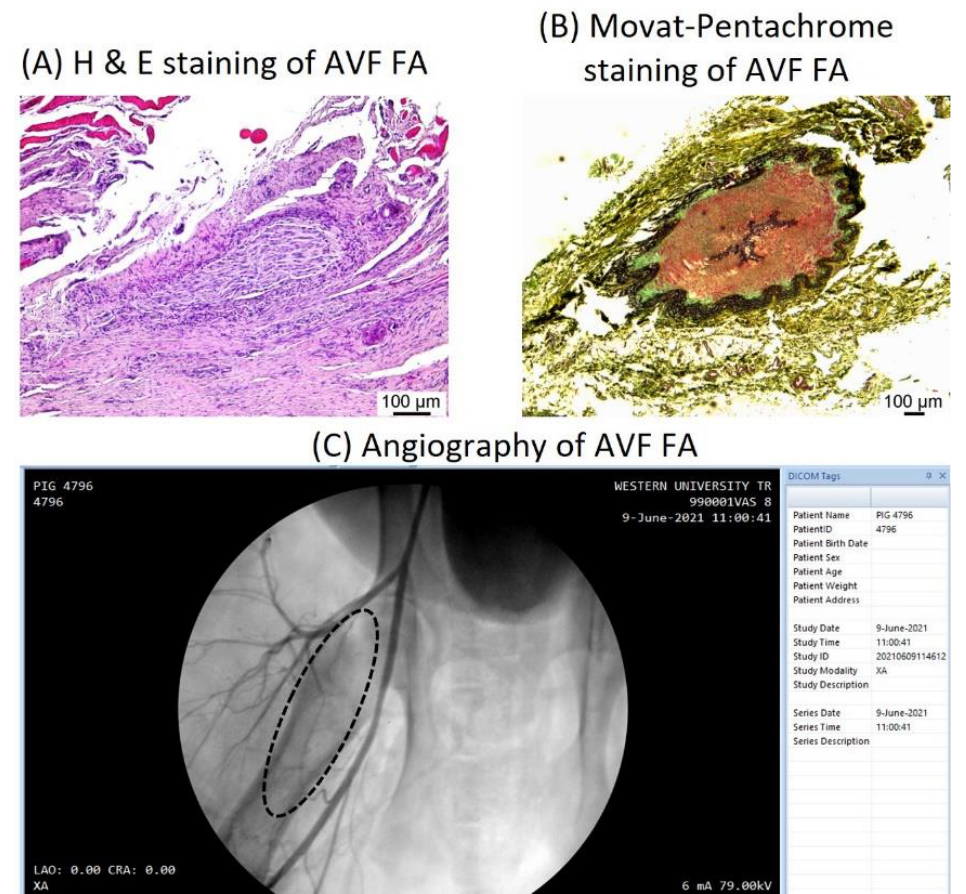
Figure 1. Histomorphological and radiological analysis of the femoral artery involved in the ar- teriovenous fistula. Hematoxylin and eosin staining ( panel A ) showed a thrombosed artery with inflammation in the adventitia. Movat-pentachrome staining ( panel B ) revealed a thrombosed artery with elastin degradation in the adventitia and increased collagen deposition in media and intima. Angiography ( panel C ) revealed a stenosed superficial femoral artery (the dotted circle) involved in AVF. These images are representative of the stenosed